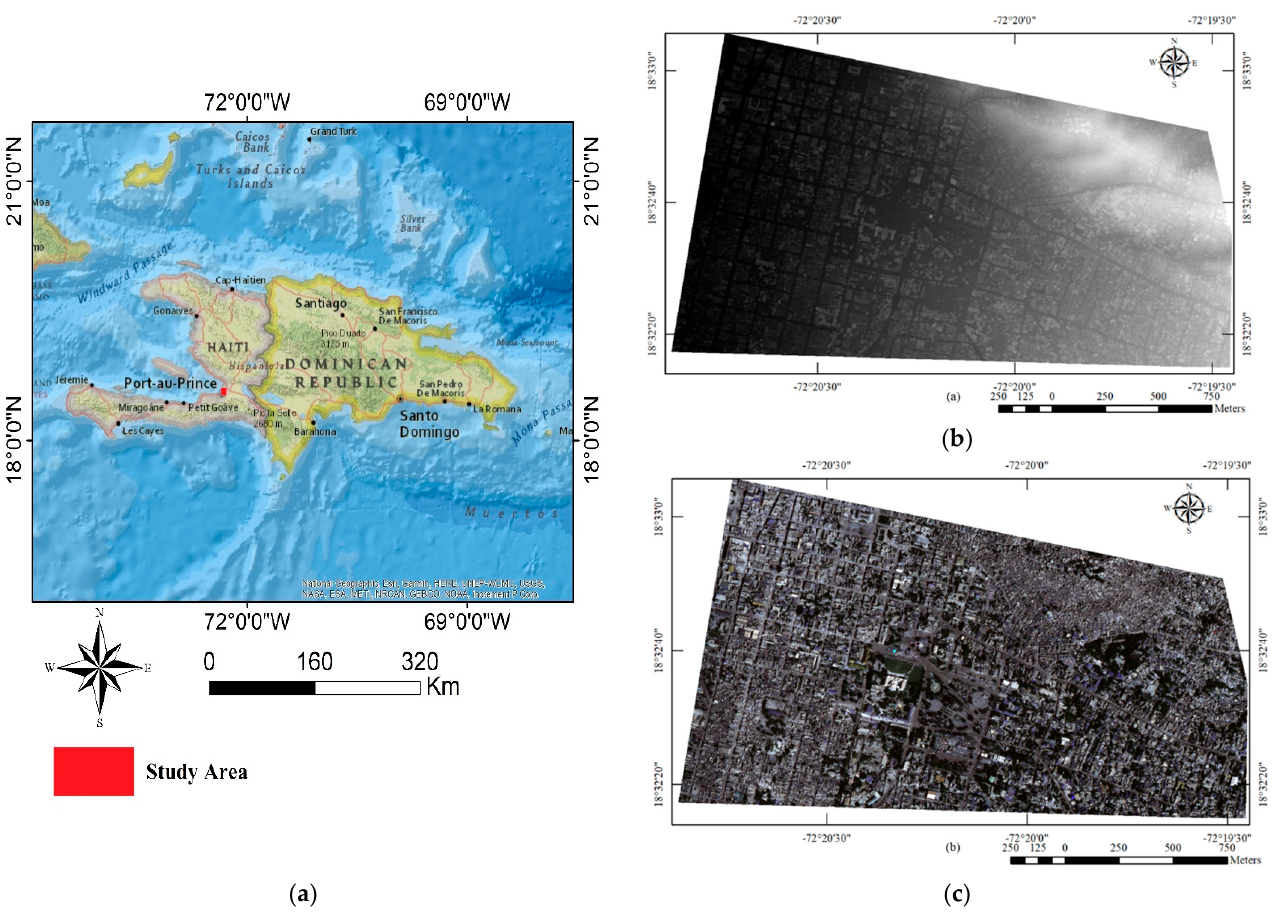
Figure 2. The location of the study area. ( a ) Map of Port-au-Prince province in Haiti; ( b ) Post-earthquake Lidar data; ( c ) Post-earthquake high-resolution data.